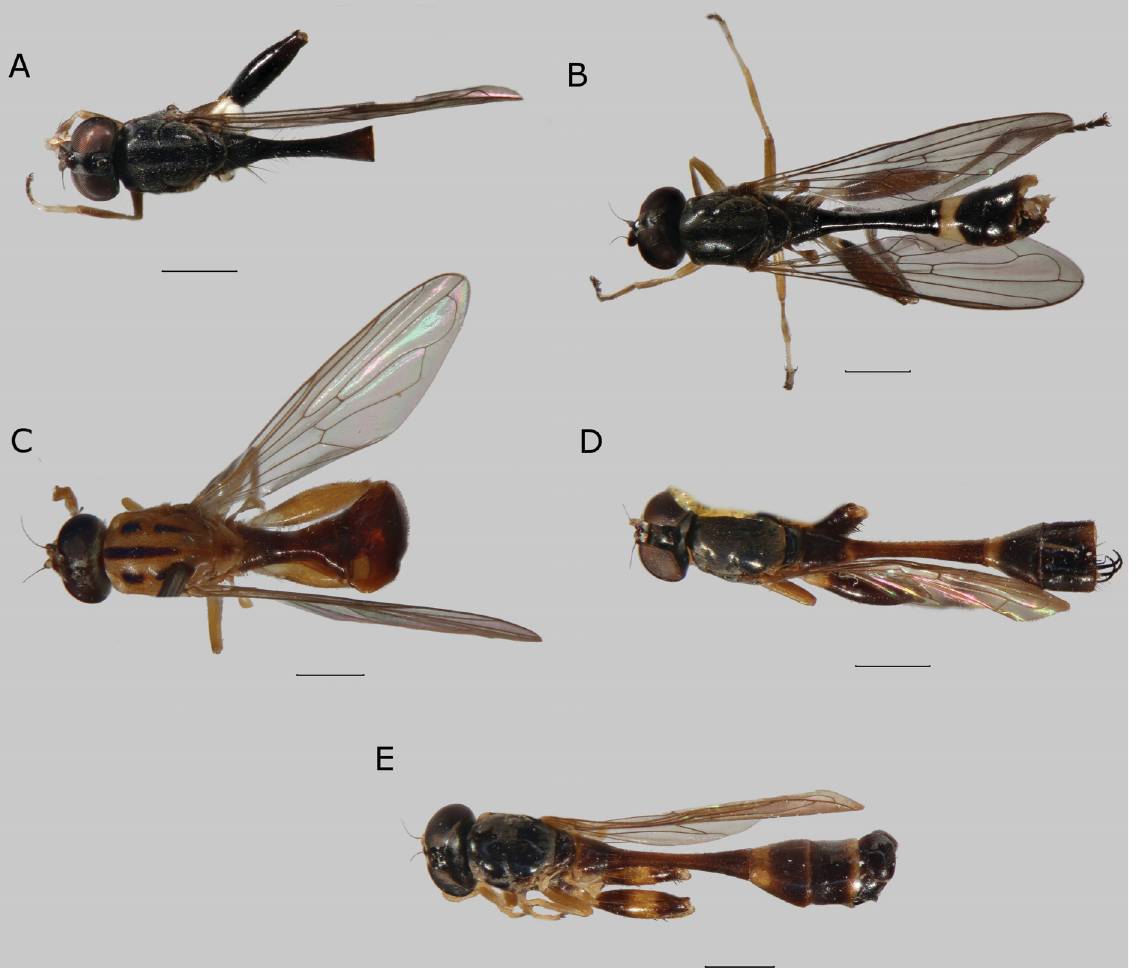
Fig. 97. Habitus, dorsal view. A . Sphegina (Asiosphegina) umbrosa sp. nov., holotype, ♂ , China. B . S. ( A.) varidissima Shiraki, 1930, ♂ , Taiwan. C . S. ( A.) vari dissima , ♀ , Taiwan, yellow form. D . S. (A.) verrucosa sp. nov., paratype, ♂ , Vietnam. E . S. ( A. ) vietnamensis sp. nov., paratype, ♂ , Vietnam. Scale bars = 1.0